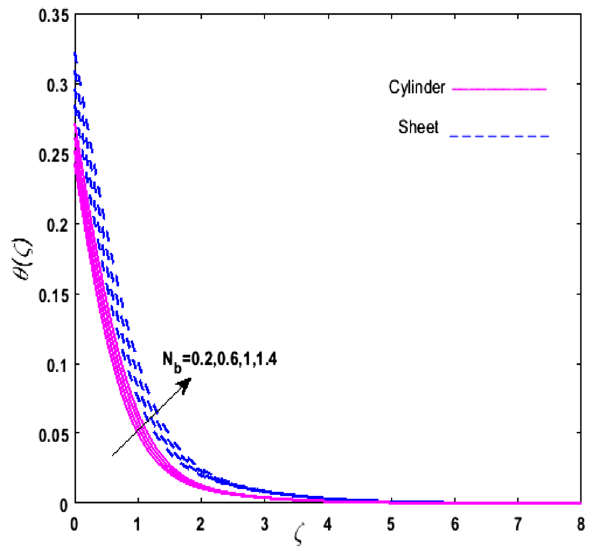
Figure 9. Upshot of N b on θ(ζ)